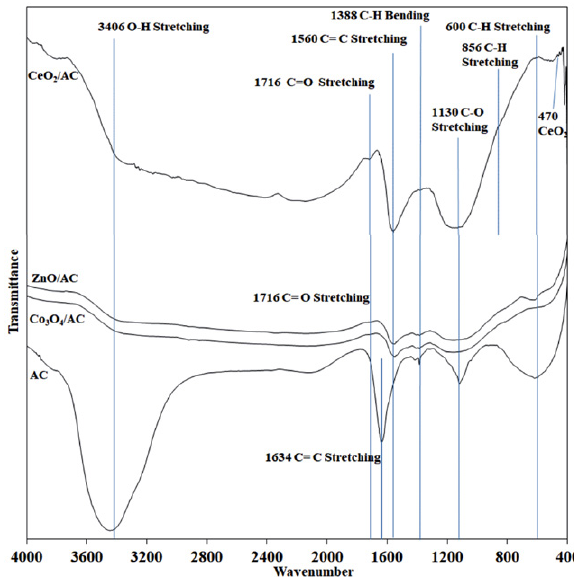
Figure 1. IR spectra of AC and various